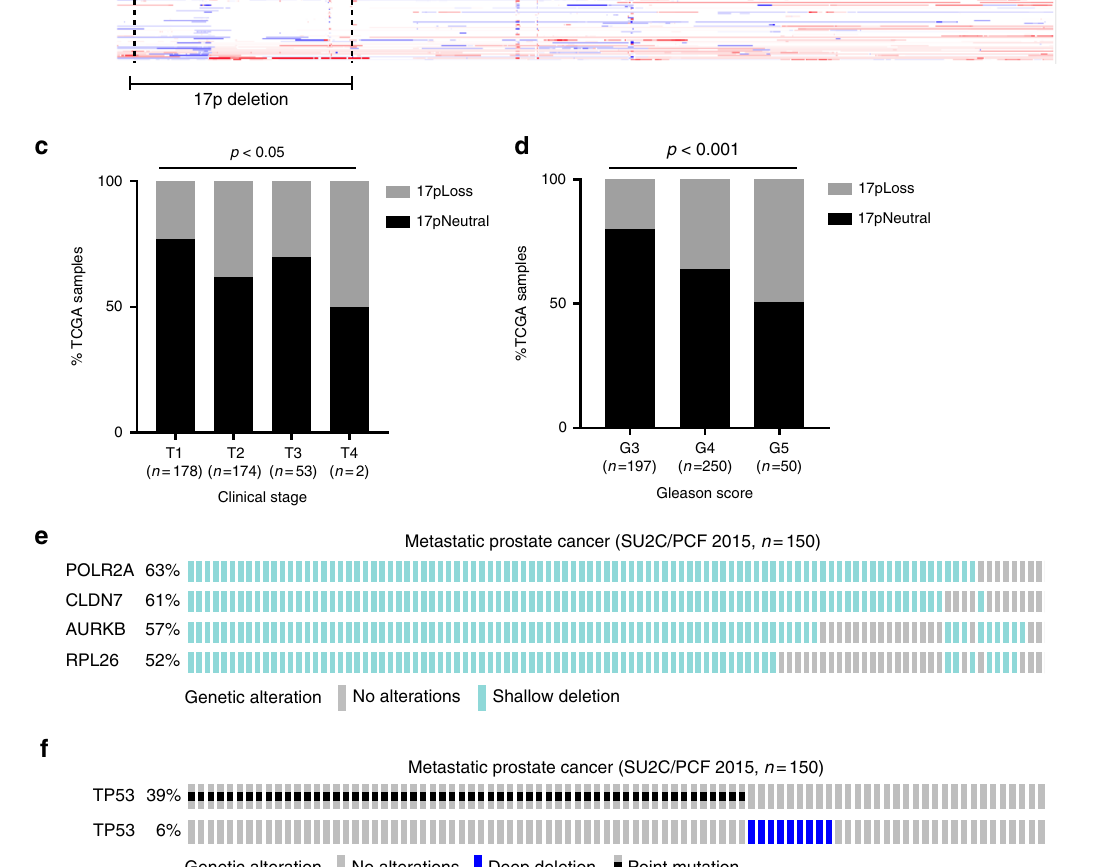
Fig. 1 Chromosome 17p loss is a frequent genomic event in prostate cancer. a Genomic alterations of TP53 (point mutation, shallow deletion and deep deletion) in a TCGA prostate cancer dataset (TCGA provisional, n = 492) determined by cBioportal. Due to the intra-tumor heterogeneity, one tumor tissue may include tumor cells with homozygous deletion of TP53 or with mutant TP53, as shown in a few cases. b Integrated analysis of 17p deletion in 155 prostate cancer patient samples. Frequency plots of the copy number abnormalities indicate degree of copy number loss (red) or gain (blue). Representative genes in 17p deletion region are shown. c , d Distribution of heterozygous deletion of 17p among tumor clinical ( c ) and pathological ( d ) stages in the TCGA prostate cancer dataset (Fisher ’ s exact test). e , f Genomic alterations of 17p heterozygous deletion ( e ) and TP53 mutations ( f ) in the TCGA metastatic prostate cancer dataset (SU2C/PCF 2015, n = 150) determined by